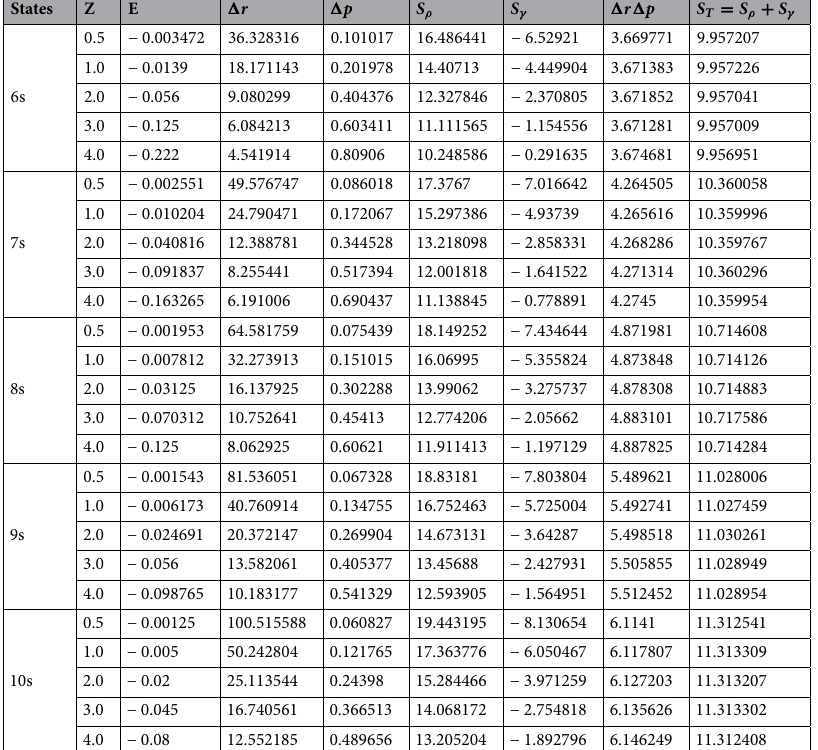
Table 1. The variation of Energy E, variance in position space (cid:31) r , variance in momentum space (cid:31) p , Shannon entropy in position space S ρ , Shannon entropy in momentum space S γ , Heisenberg uncertainty principal (cid:31) r (cid:31) p and uncertainty relation based on entropy S T = S ρ + S γ with atomic number Z and principal quantum number n for Rydberg linear states of free Hydrogen-like atoms.